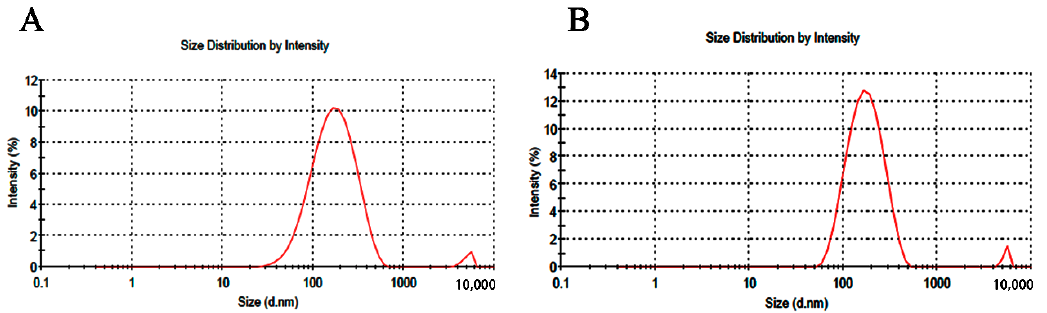
Figure 7. Size distribution of receiver samples ( A ) Samples of TGP ‐ E in ex vivo skin permeation at